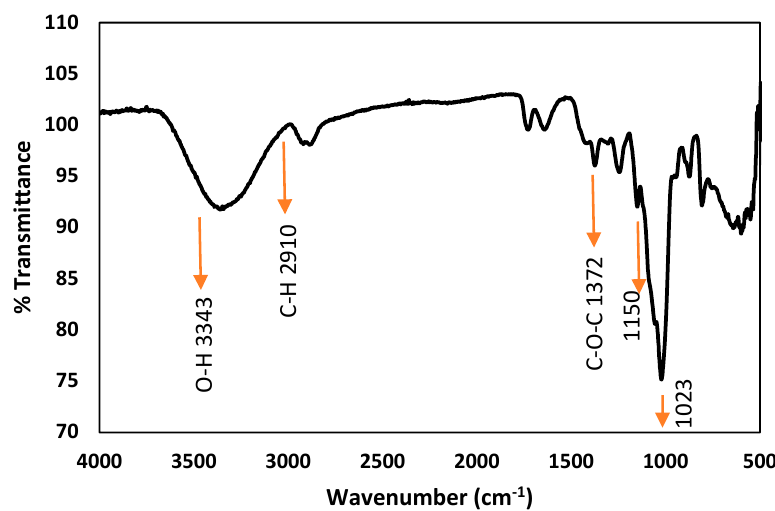
Figure 1. FTIR characterizations of Bletilla striata polysaccharide (BSP).